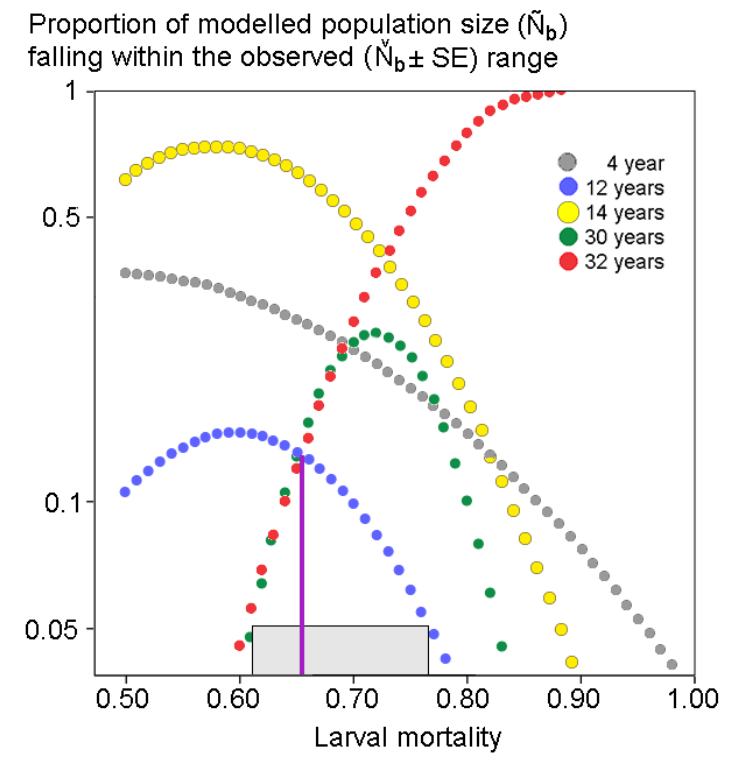
Figure A4. The probability of modeled population sizes of Chioglossa lusitanica at Ribeira de Silveirinhos falling within the population size range estimated in the field( Ň ± SE), as a function of larval mortality ( q l , horizontal axis). Adult mortality q b = 0.28, otherwise as in Figure 4. Support is maximal for q l = 0.65 (purple bar, p > 0.10). The grey rectangle indicates the 0.61 < q l < 0.77 range over which none of the Ñ– Ň combinations are implausible ( p >